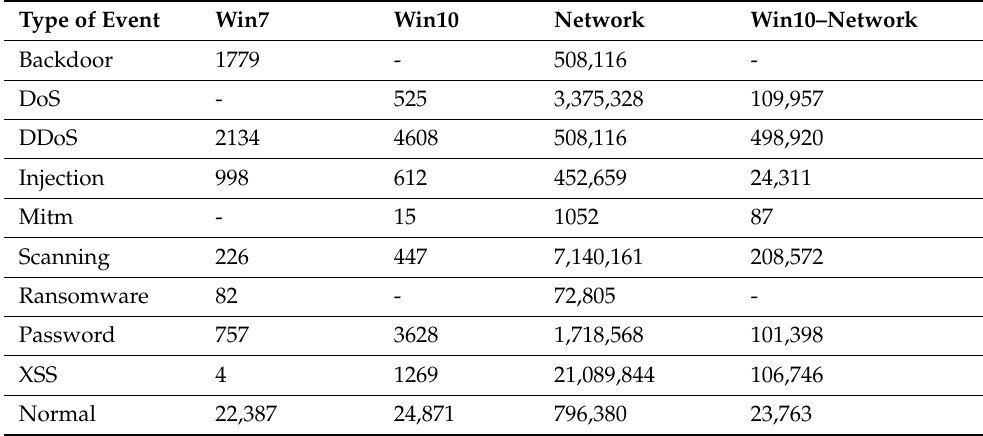
Table 3. The numbers of normal records and the types of attachments collected in the Win7, Win10, Network, and Win10–Network